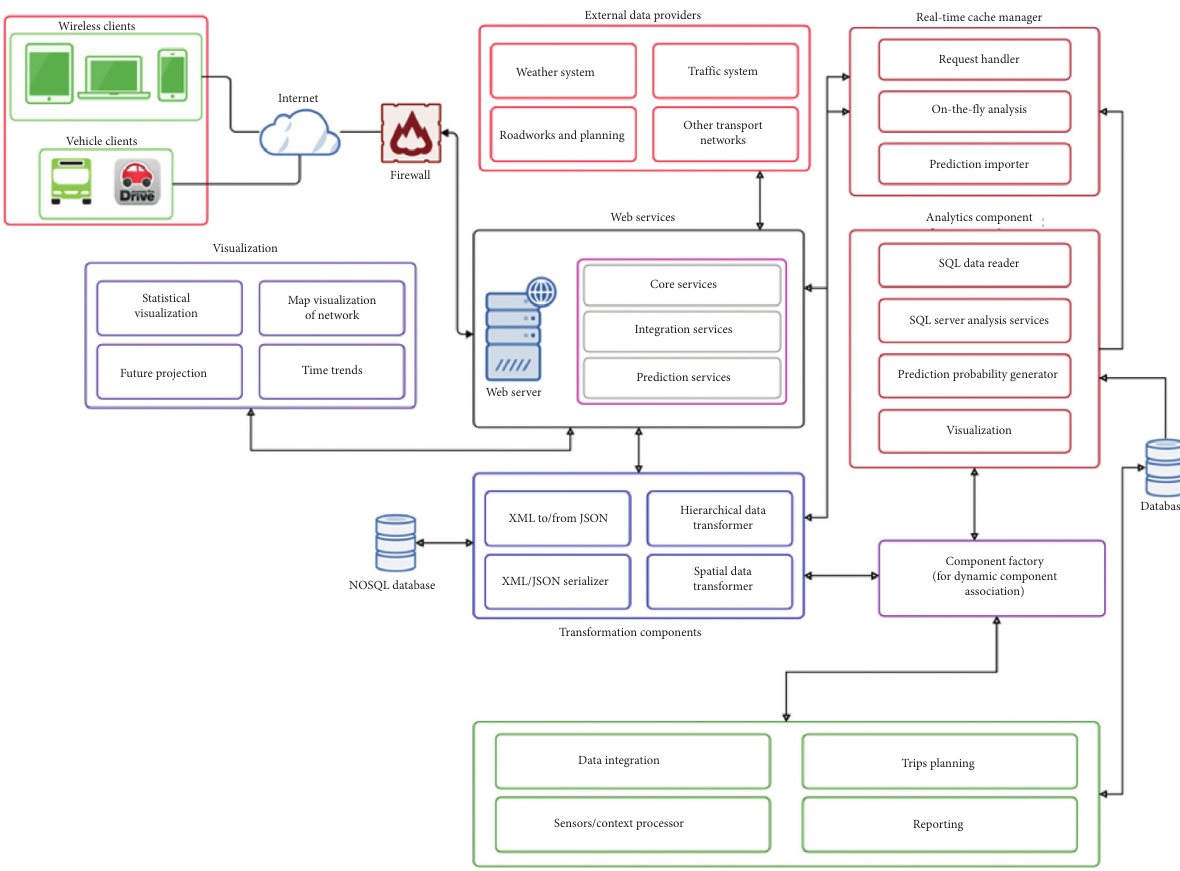
Figure 1: Modules of the proposed system architecture and their